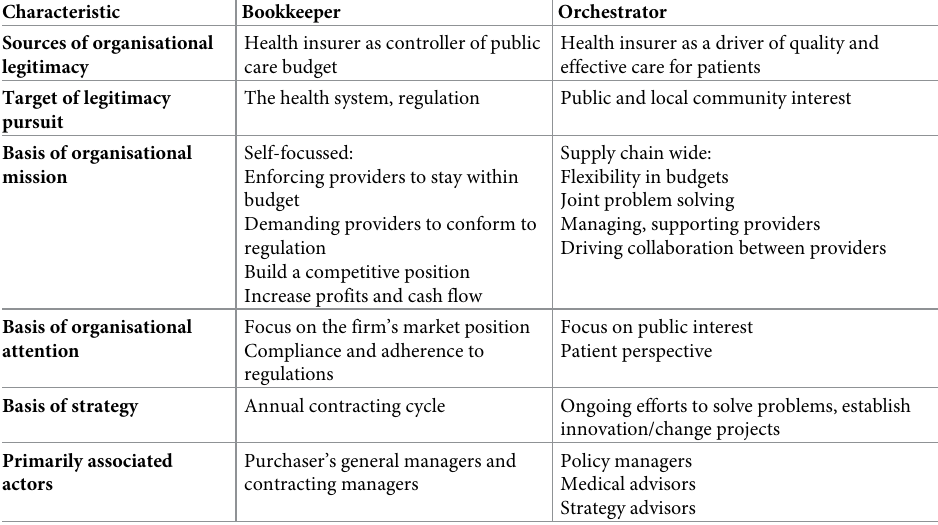
Table 3. Ideal types of the identified bookkeeper’s and orchestrator’s institutional